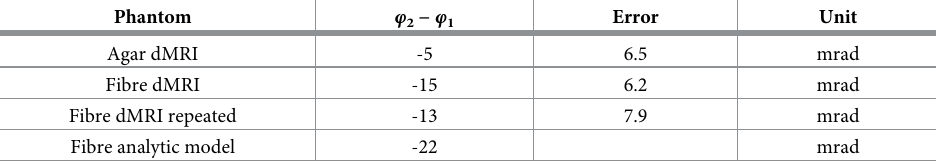
Table 5. The difference in the mean phase between the two separation times Δ 1 and Δ 2 . The error was computed by error propagation of the errors presented in Fig